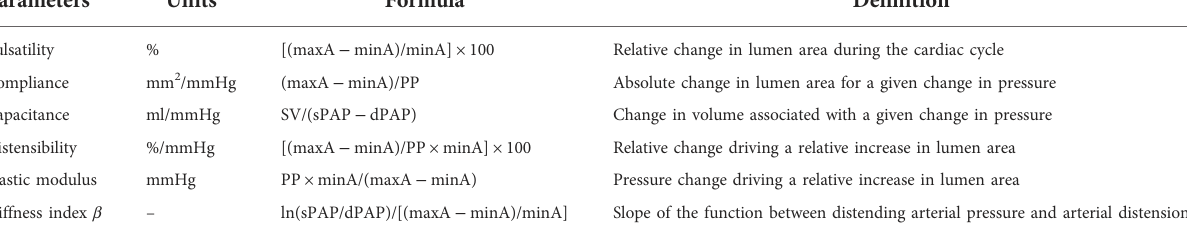
TABLE 1 Indices of pulmonary arterial stiffness.